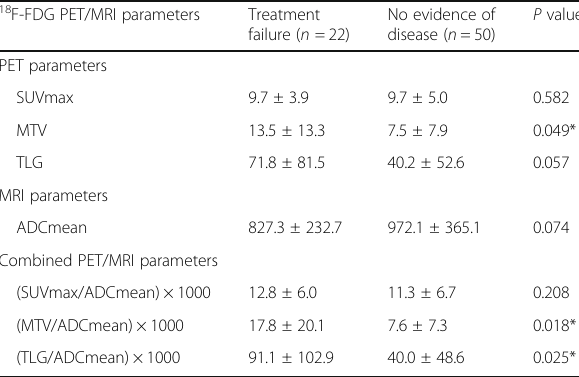
Table 3 Comparison of 18 F-FDG PET/MRI parameters according to head and neck cancer treatment failure after surgery 18 F-FDG PET/MRI